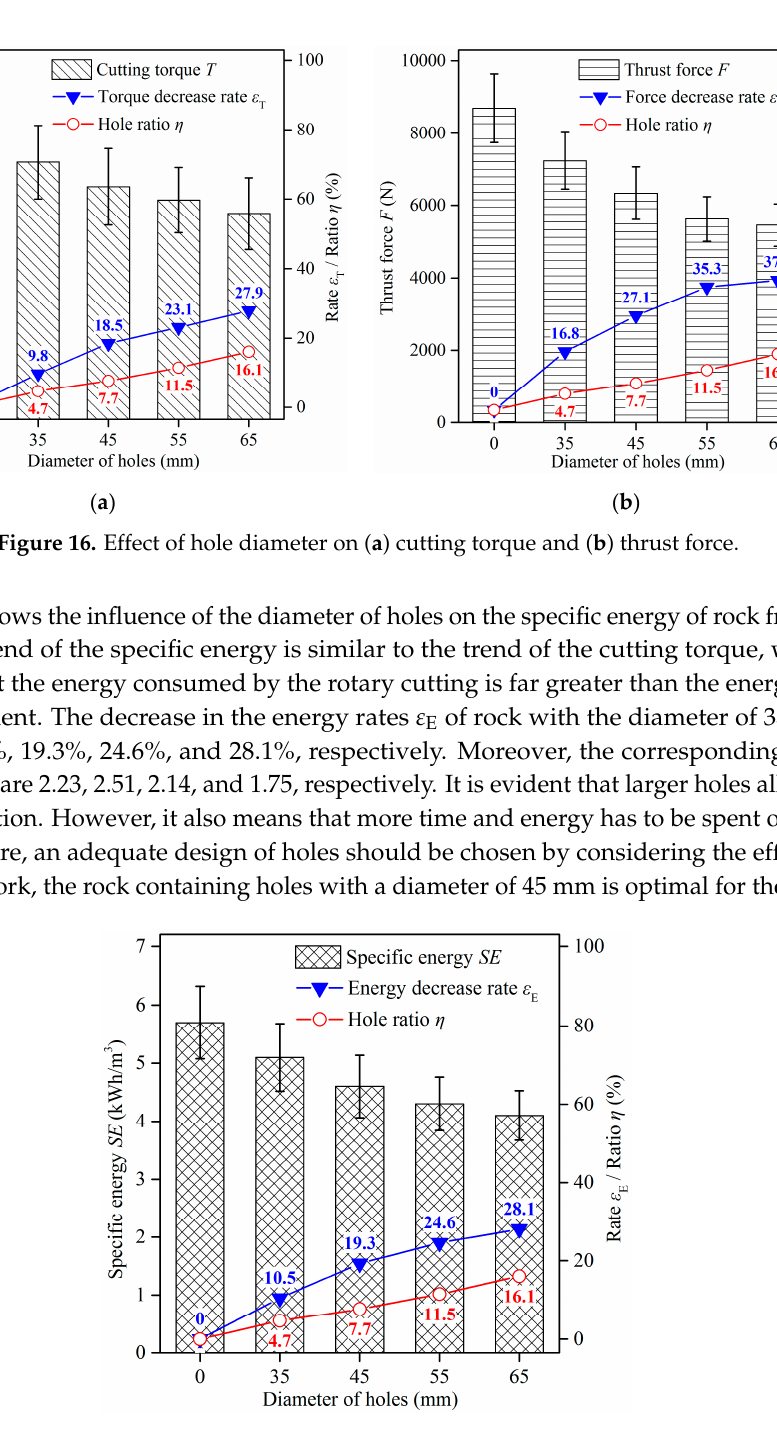
Figure 17. Effect of hole diameter on specific energy.